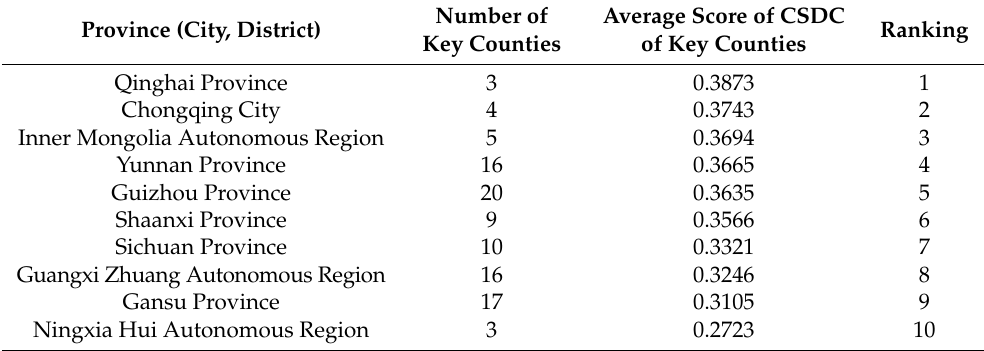
Table 2. Average sustainable development capacity score of key counties to receive assistance in each province (city and